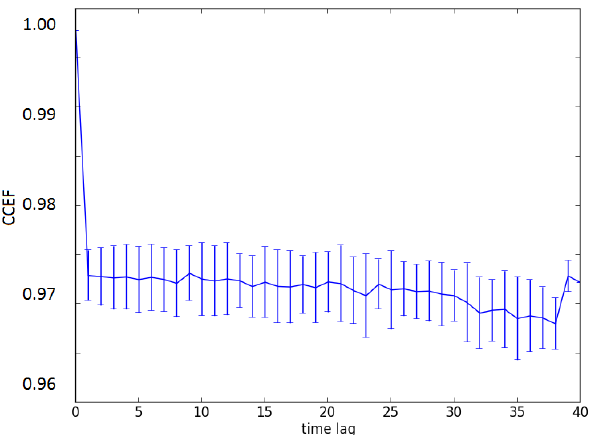
Figure 4. CCEF of annual climate networks for the time period 1970–2011CE. Error bars are presented as CCEF standard devia- Fig. 4: CCEF of annual climate networks for the time period tion of the respective time lag in 1970-2011 C.E., error bars are presented as CCEF standard deviation of the respective time lag in years.